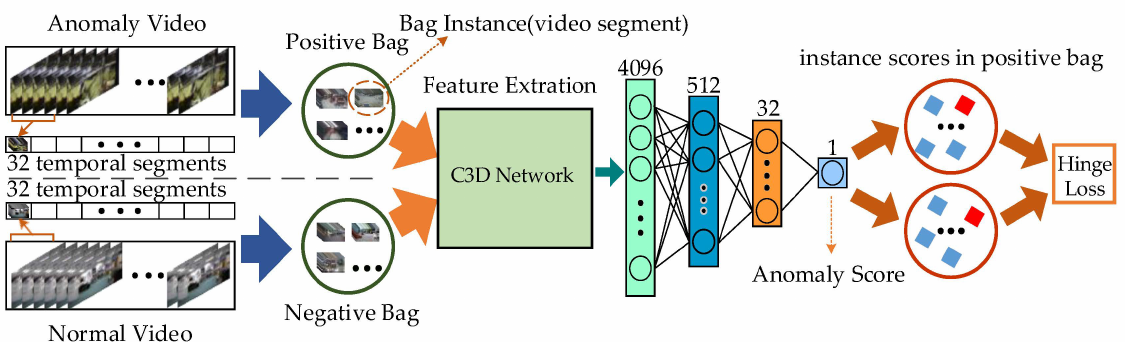
Figure 1. Multiple-instance learning. The surveillance video is divided into a fixed number of video segments, and the segments are placed in positive and negative bags. Each video segment is called an instance in the bags [15]. Then, the feature extraction network is used to extract features from the fixed number of video clips in the two bags. Next, the multilayer perceptron is used to calculate the anomaly scores of the features. Finally, the scores are used to determine whether there is abnormal